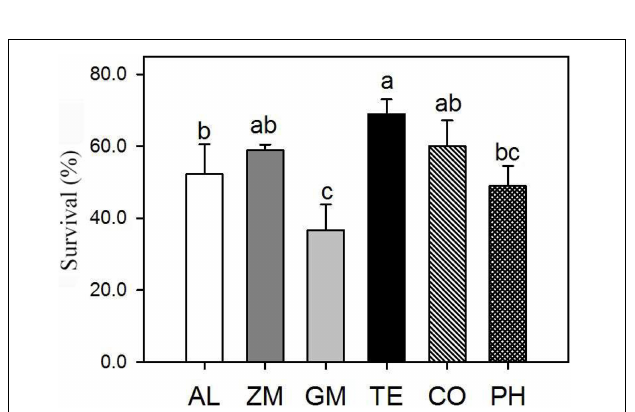
FIGURE 1 | Typical GC-MS chromatogram of several classical volatile oils presents in A. lancea .